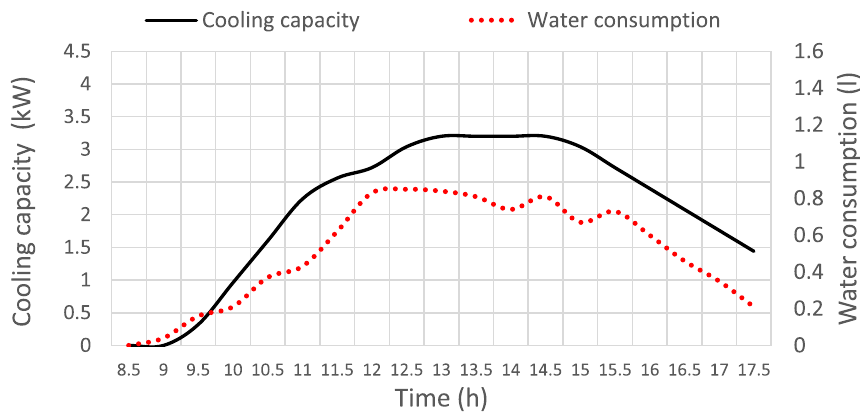
Fig. 12 Variation of cooling capacity and water consumption with time for day 2